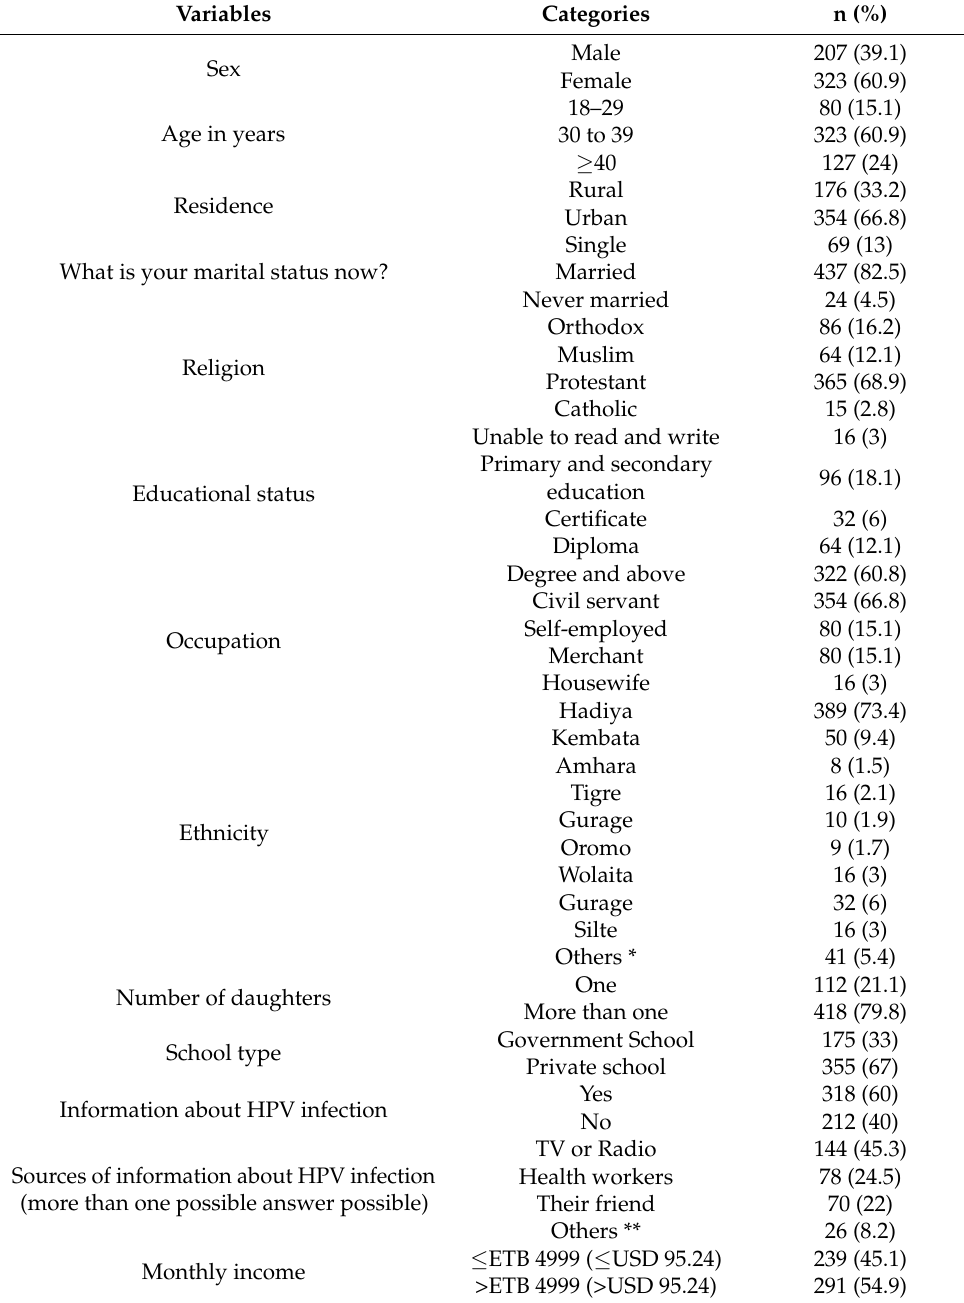
Table 1. Sociodemographic-related characteristics of the respondents on awareness, acceptance, and associated factors of human papillomavirus vaccine among parents of daughters in Hadiya zone, southern Ethiopia, 2021 (n =